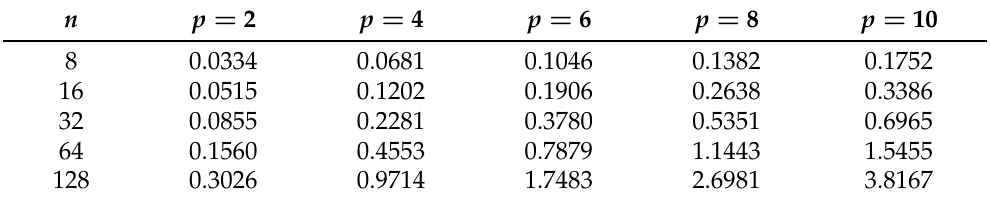
Table A5. Execution time (sec) of PDIST . EncodeX operation on Raspberry Pi.